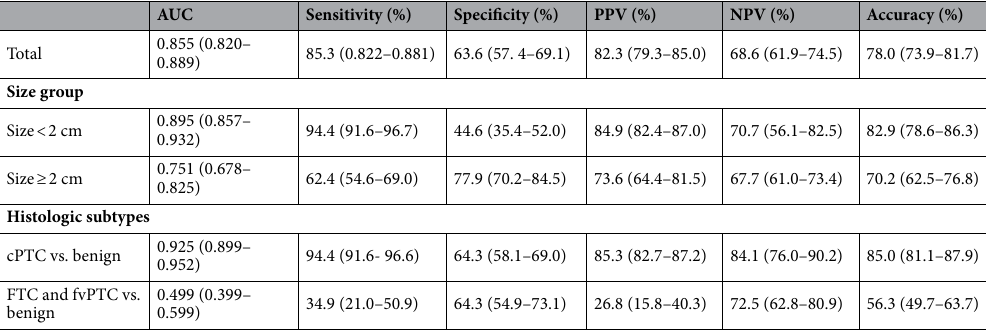
Table 2. Diagnostic performance of computer-aided diagnosis (CAD). Values (95% confidence intervals). AUC, area under the curve; PPV, positive predictive value; NPV, negative predictive value; cPTC, conventional